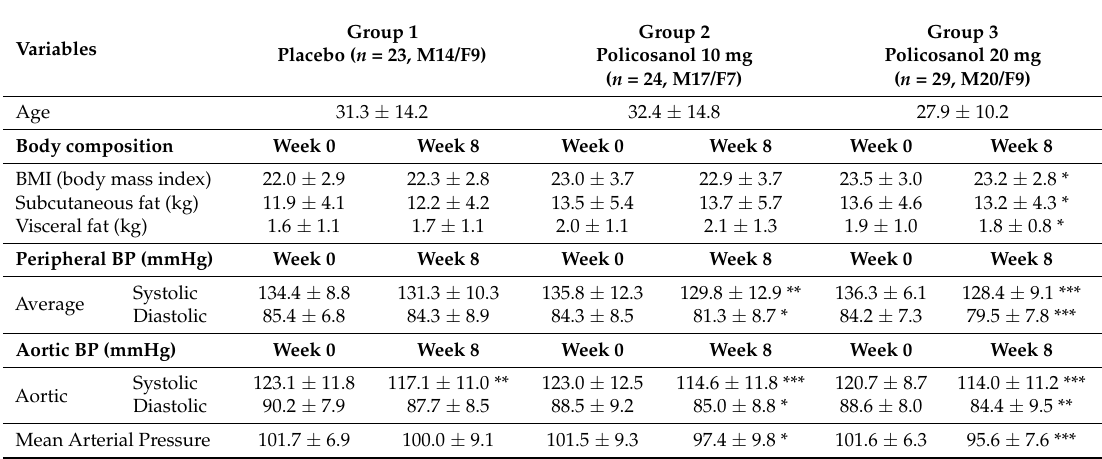
Table 1. Change of blood pressures after 8-week policosanol consumption.